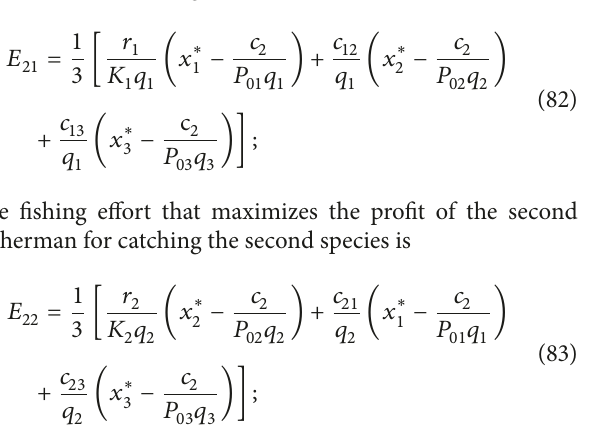
Table 4: The influence of the price on the